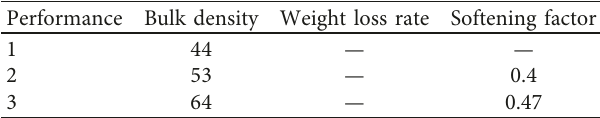
Table 2: The effect of boric acid doping on the properties of low- temperature foam glass.